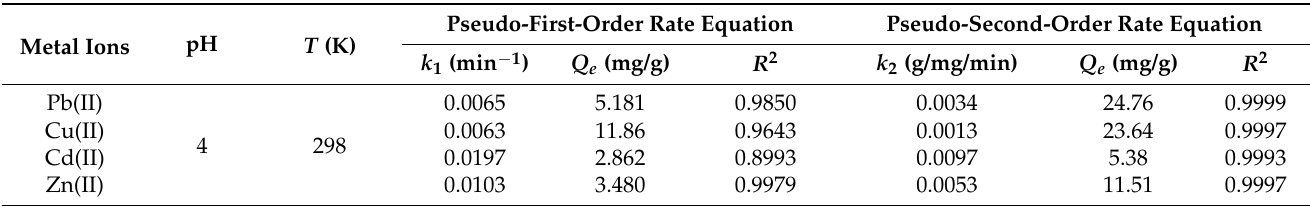
Table 3. Fitting parameters of the pseudo-first-order and pseudo-second-order kinetic models.